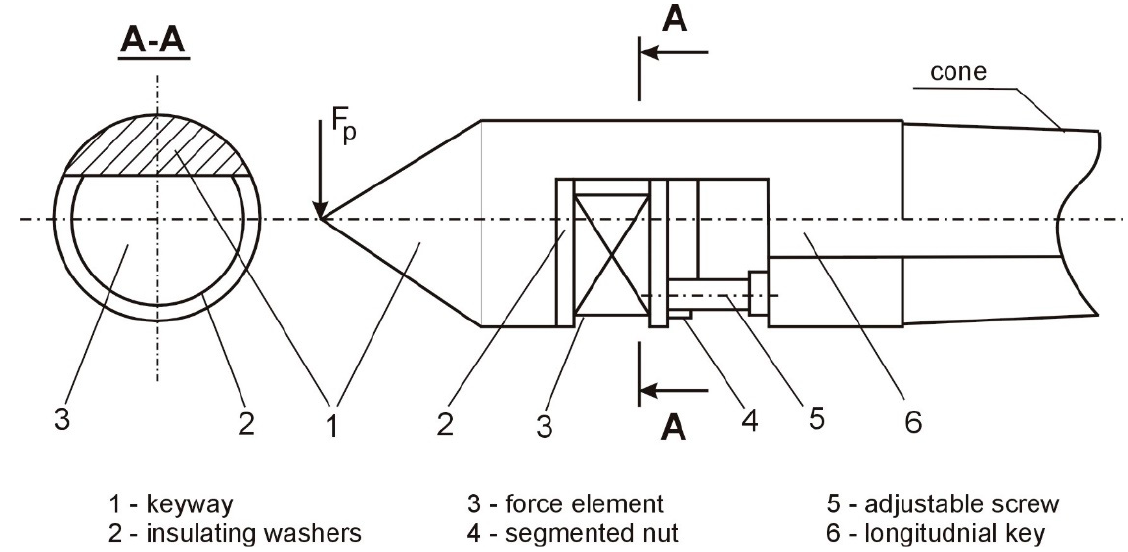
Figure 2. The structure of the claw with adjustable stiffness.